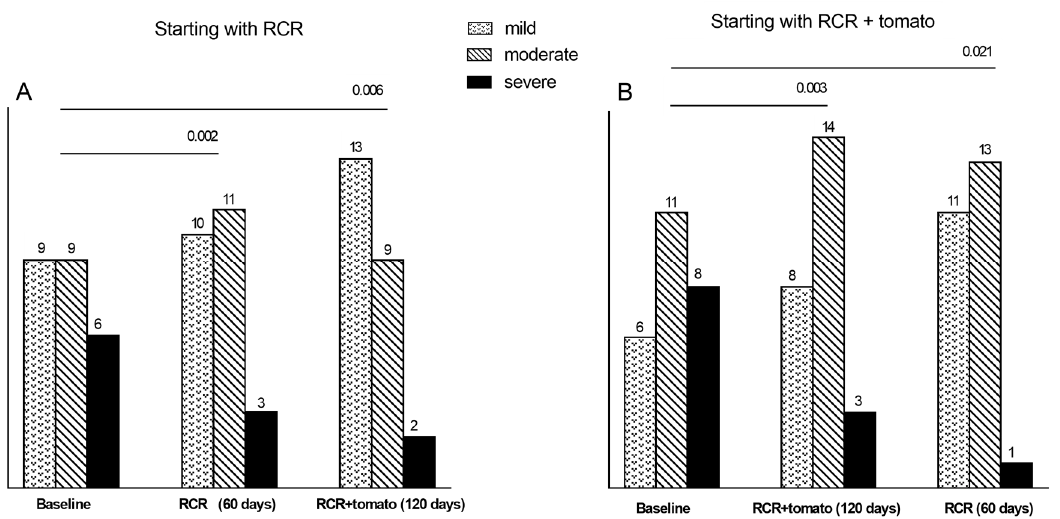
Figure 4. Stratification of patients by degrees of steatosis based on ultrasound findings at the baseline, 60 and 120 days. ( A ) group 1; ( B ) group